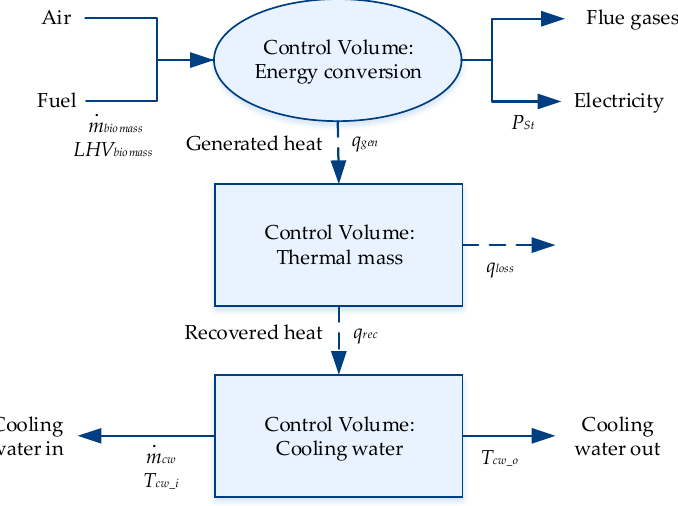
Figure 10. Mass and energy flow diagram of the Stirling engine model [62].